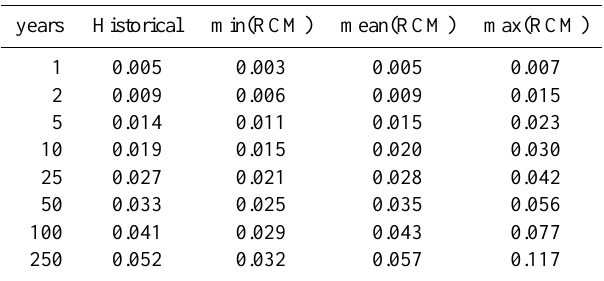
Table 2. Modelled damage ratios (% of total value) to the European population density-derived portfolio using the RCM and historical storm